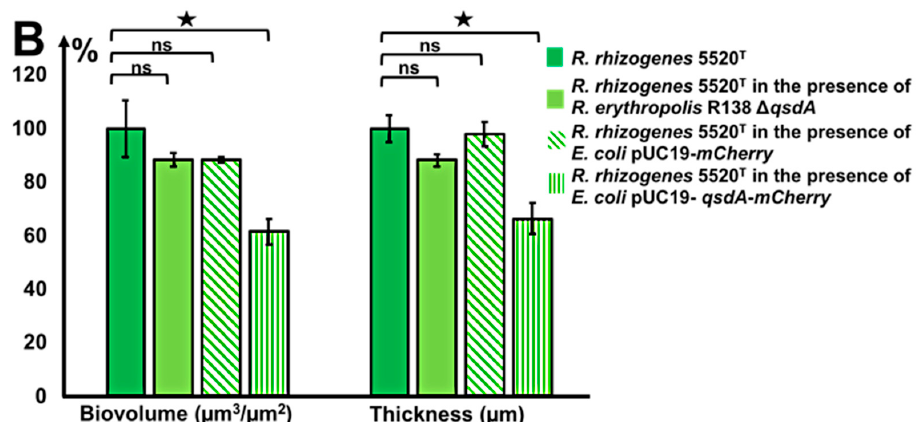
Figure 5. Effects of the R. erythropolis Δ qsdA deletion mutant and of QsdA AHL-lactonase-producing E. coli strains on R. rhizogenes biofilm formation. CLSM analysis of the dual-species biofilm formed by R. rhizogenes 5520 T (green fluorescence) and R. erythropolis R138 (or E. coli) (red fluorescence) (1:1 ratio). R. rhizogenes and rhodococcal (or E. coli) bacteria were tagged with GFP and mCherry via the pHC60-gfp and pEPR1(or pUC19)-mCherry vectors, respectively. 3D representation and side view of the dual-species biofilm formed by R. rhizogenes and R. erythropolis Δ qsdA ( A1 ), R. rhizogenes and E. coli pUC19-mCherry ( A2 ), and R. rhizogenes and E. coli pUC19-qsdA-mCherry ( A3 ) (activatation of the green or red channel is indicated by a light spot of the corresponding color). COMSTAT analysis of the biovolume and thickness of the biofilms developed. R. rhizogenes biofilm, biovolume, and thickness values were set to 100%, for use as a reference in comparison with mixed biofilm conditions ( B ). The data shown are the means of three measurements from three independent experiments. Significant differences in biovolume and thickness values (Mann–Whitney test; p -value < 0.01) are indicated by asterisks ( ★ p < 0.05); ns, not significant.